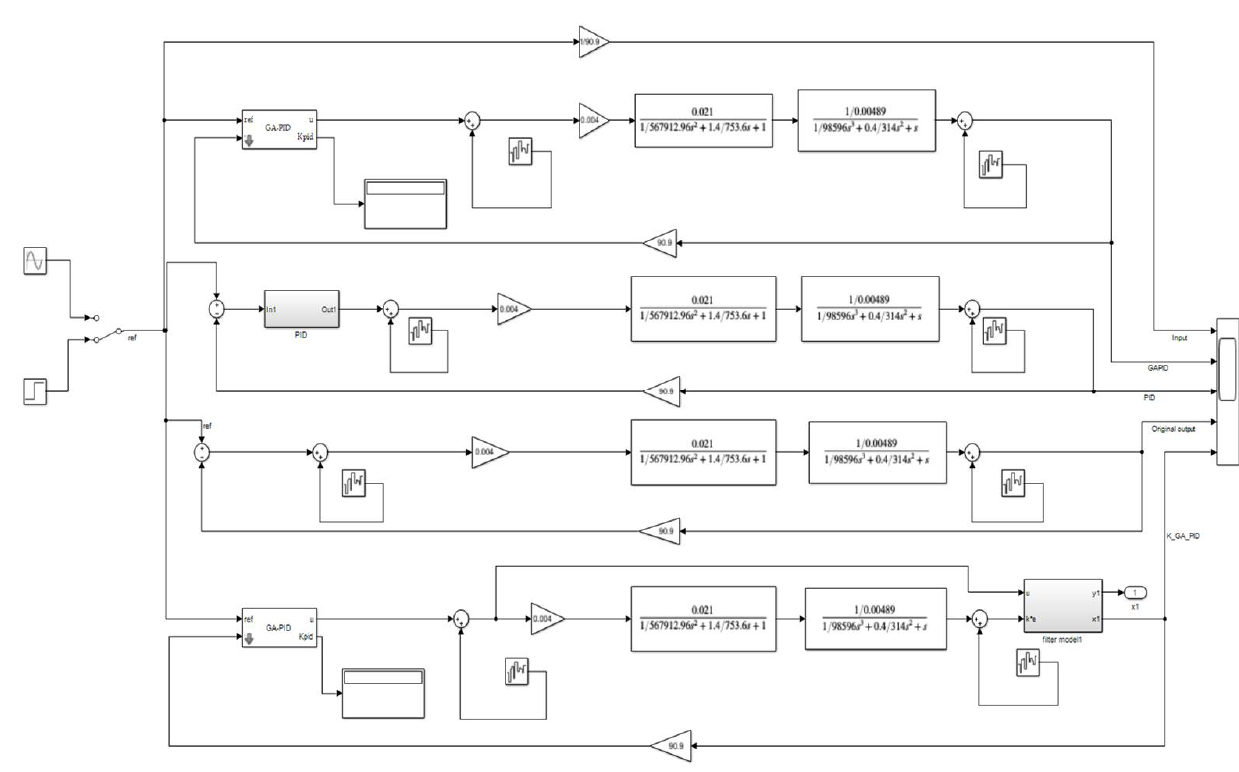
Figure 11. System Simulation Diagram of Kalman filter-optimized genetic PID. The system noise and observation noise are set to 0.002 energy white noise, as shown in Figure 12. At the same time, the covariance Q and R of system noise ω k and observation noise ν k are set to 1, and the step signal and sinusoidal signal are taken as the input of the system. The step response and sinusoidal response, as shown in Figure 9a,b, under PID control, GA-optimized PID control, and Kalman- and GA-optimized PID control are compared and analyzed. The system simulation results are shown in Figure 13a,b. The corresponding outputs of the PID control and the GA-optimized PID controller are shown in Figure 13a,b for the case of step and sinusoidal signal inputs, respectively.